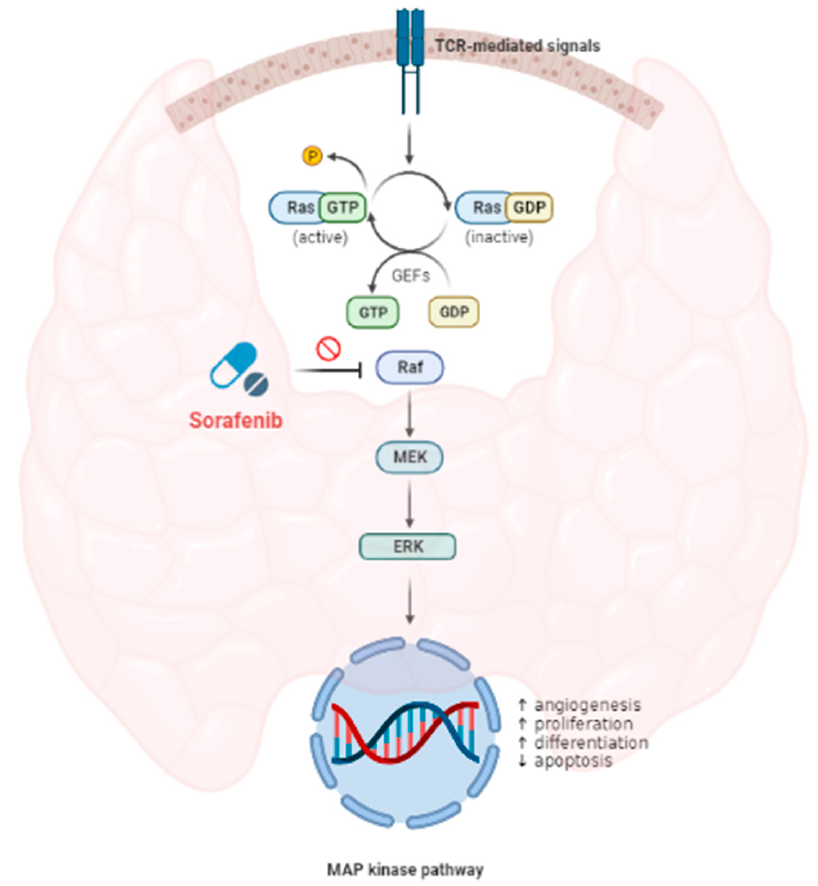
Figure 1. MAP kinase pathway and Sorafenib effect on cascade sequencing.